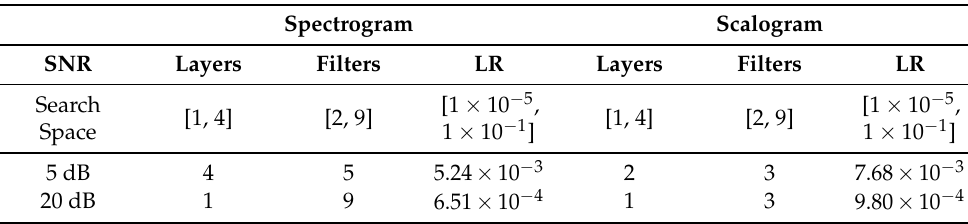
Table 5. Number of convolution layers and filters and the initial learning rates (LRs) for the CNN chosen through Bayesian optimization for classification of the interior filling (solid, air, or oil octane). The hyperparameter search space is also reported.